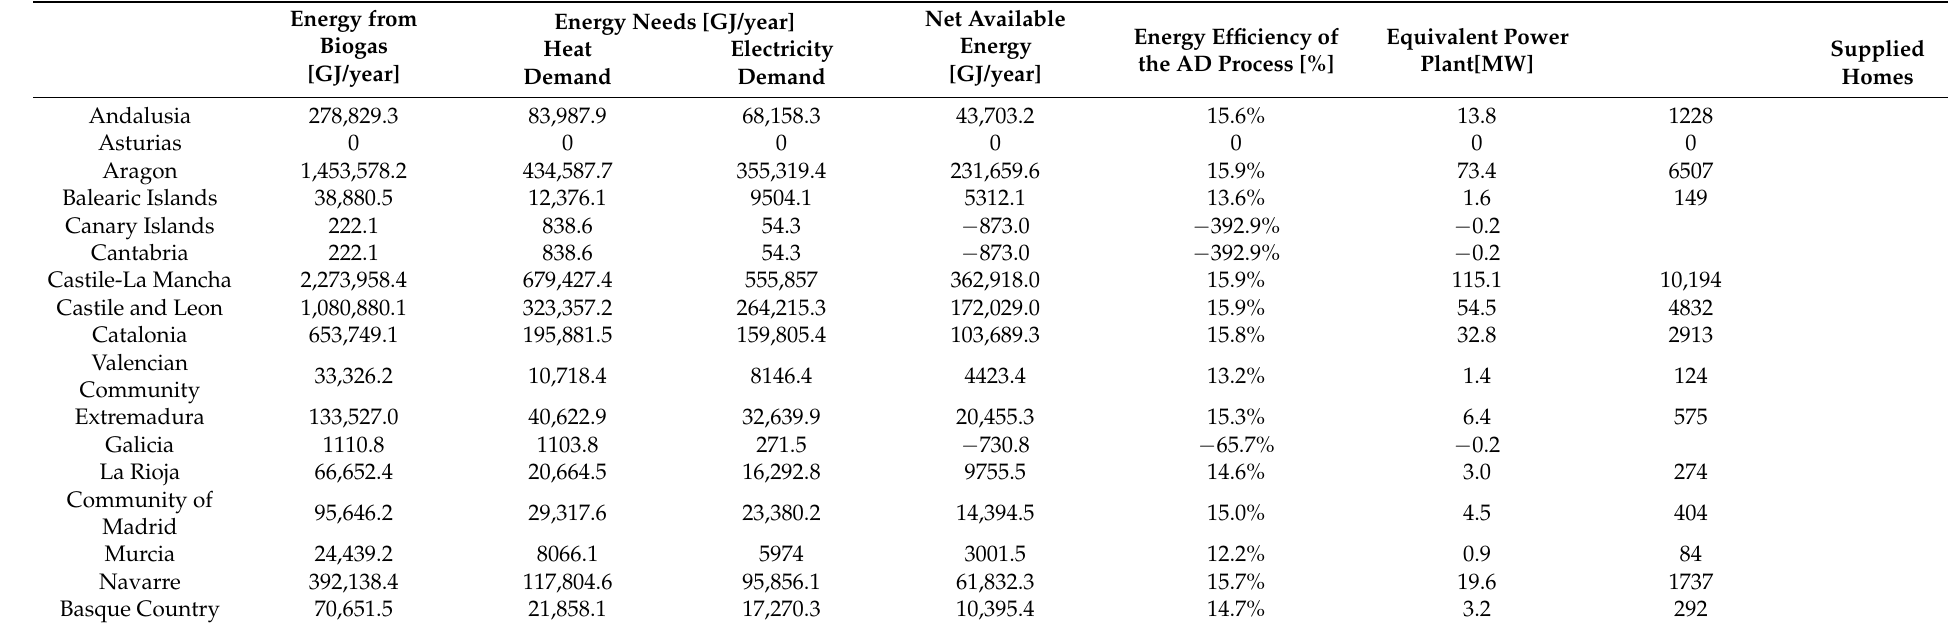
Table 8. Estimation of the energy balance of CrM’s anaerobic